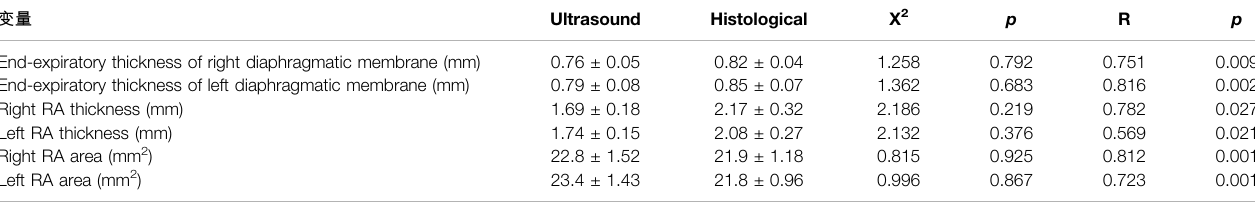
TABLE 2 | Concordance and correlation between ultrasound and histological measurements. 变 量